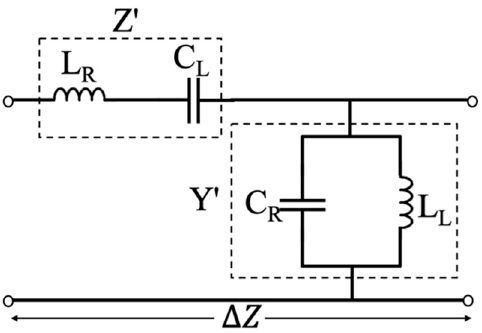
Figure 2. Equivalent Circuit of composite right/left-handed transmission line (CRLH TL) unit cell. As shown in Figure 2, the CRLH TL unit cell consists of LH series capacitor ( C L ) and shunt inductor ( L L ) with parasitic RH series inductor ( L R ) and shunt capacitor ( C R ). Its general propagation constant can be obtained as: